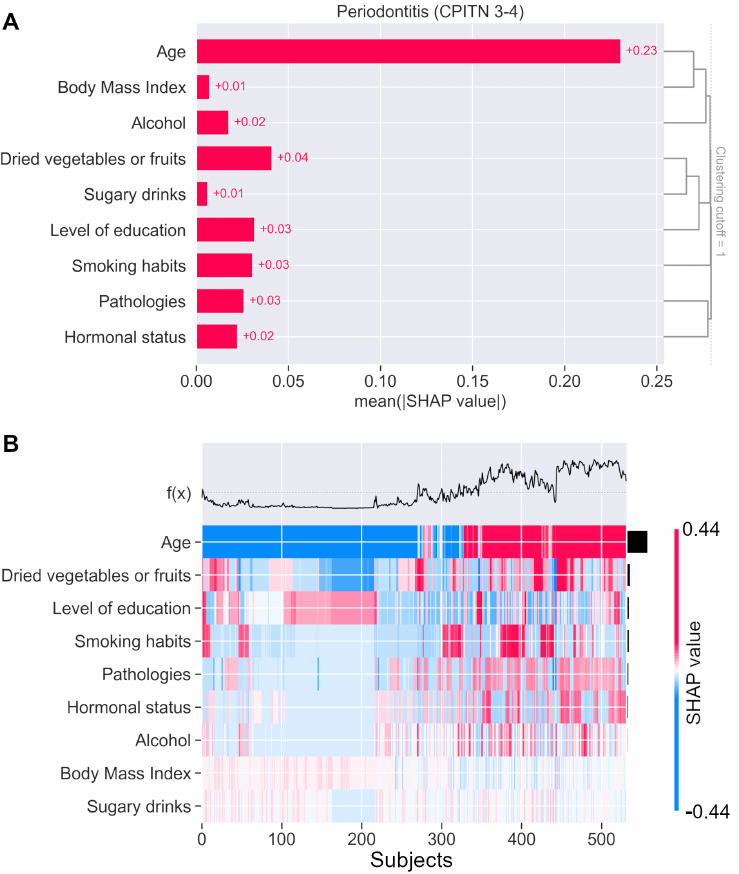
Figure 6. SHAP values correlation and clustering on periodontitis prediction. ( A ) SHAP bar plot clustering (right side) displays the redundancy structure as a dendrogram. Age mainly correlates with BMI and alcohol consumption, while pathologies are strongly associated with hormonal status. Diet seems to be rather dependent on the level of education. ( B ) The SHAP values clustering on the whole population highlights the different risk factor combinations that may explain the prediction of a periodontitis diagnosis. f(x) is the predicted probability of periodontitis. Each variable’s SHAP contribution on periodontitis prediction is represented in color by